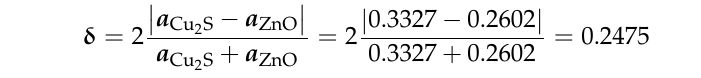
Figure 8. The XRD patterns of Cu 2 S/glass films.